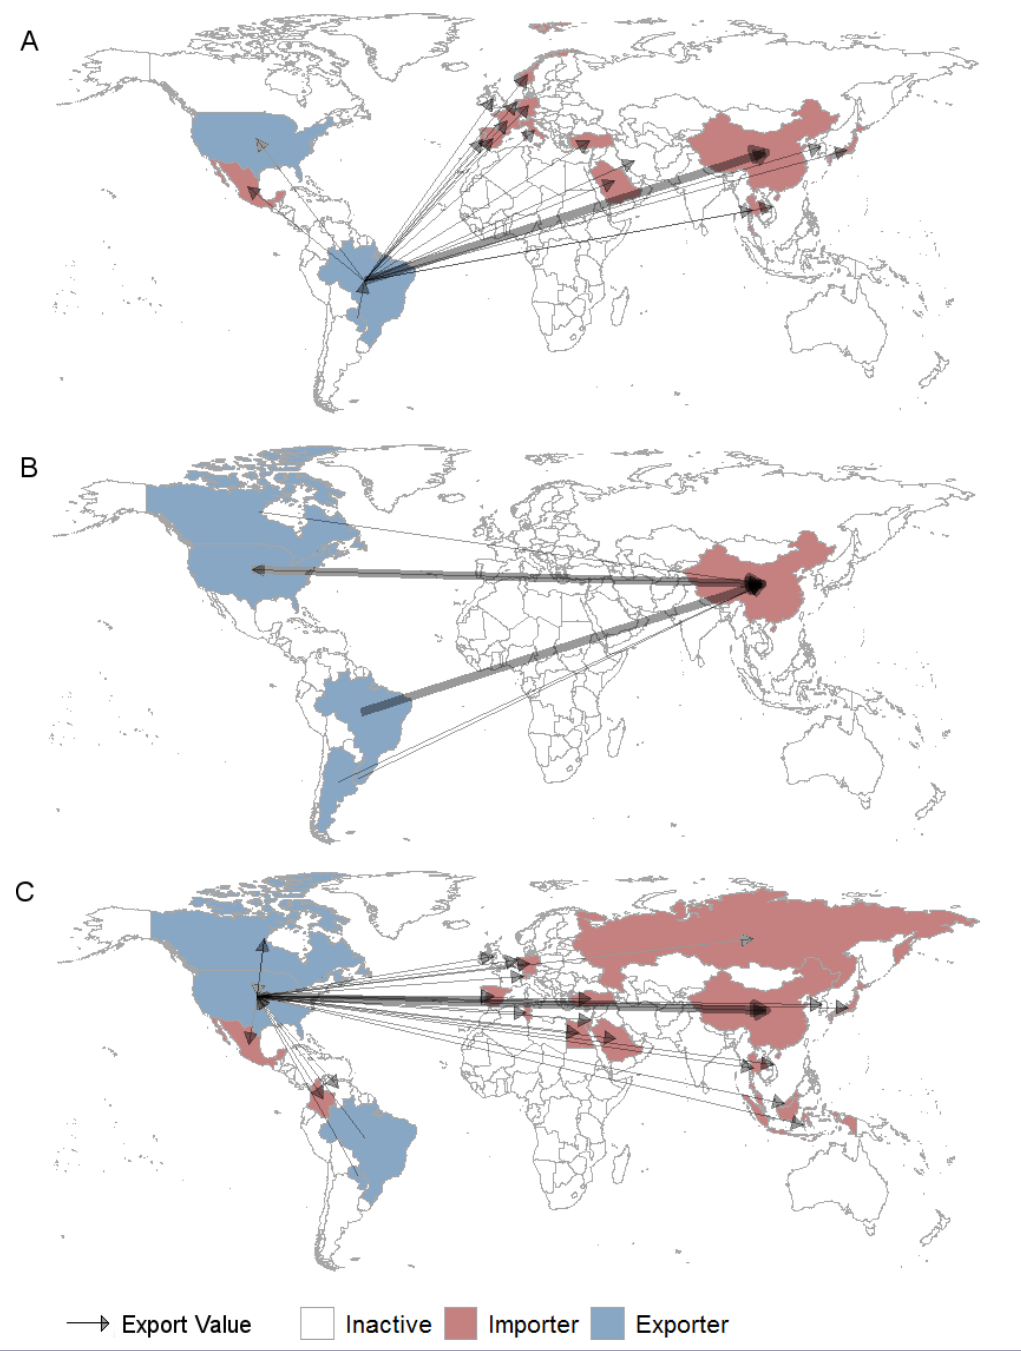
Fig. 3 . Focal soybean metacoupled system countries’ relationships in 2013: (A) Brazil’s trade relationships, (B) China’s trade relationships, (C) USA trade relationships. Countries are color coded based on whether they are net sending systems (blue), or net receiving systems (red) in each subnetwork. Arrows indicate the direction of soybean trade flows and the arrow width is weighted by the total export value (million US$) of each transaction between trade partners. For illustration purposes, only countries that participated in greater than average annual transactions are shown. Although China also exports soybean, it is a net importer. Conversely, Brazil and the U. S. also import soybean, despite the fact that both are net